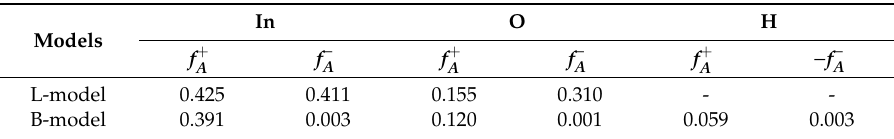
Table 2. Values of condensed Fukui function for In, O, and H atom in L-model and B-model based on Hirshfeld charge population.